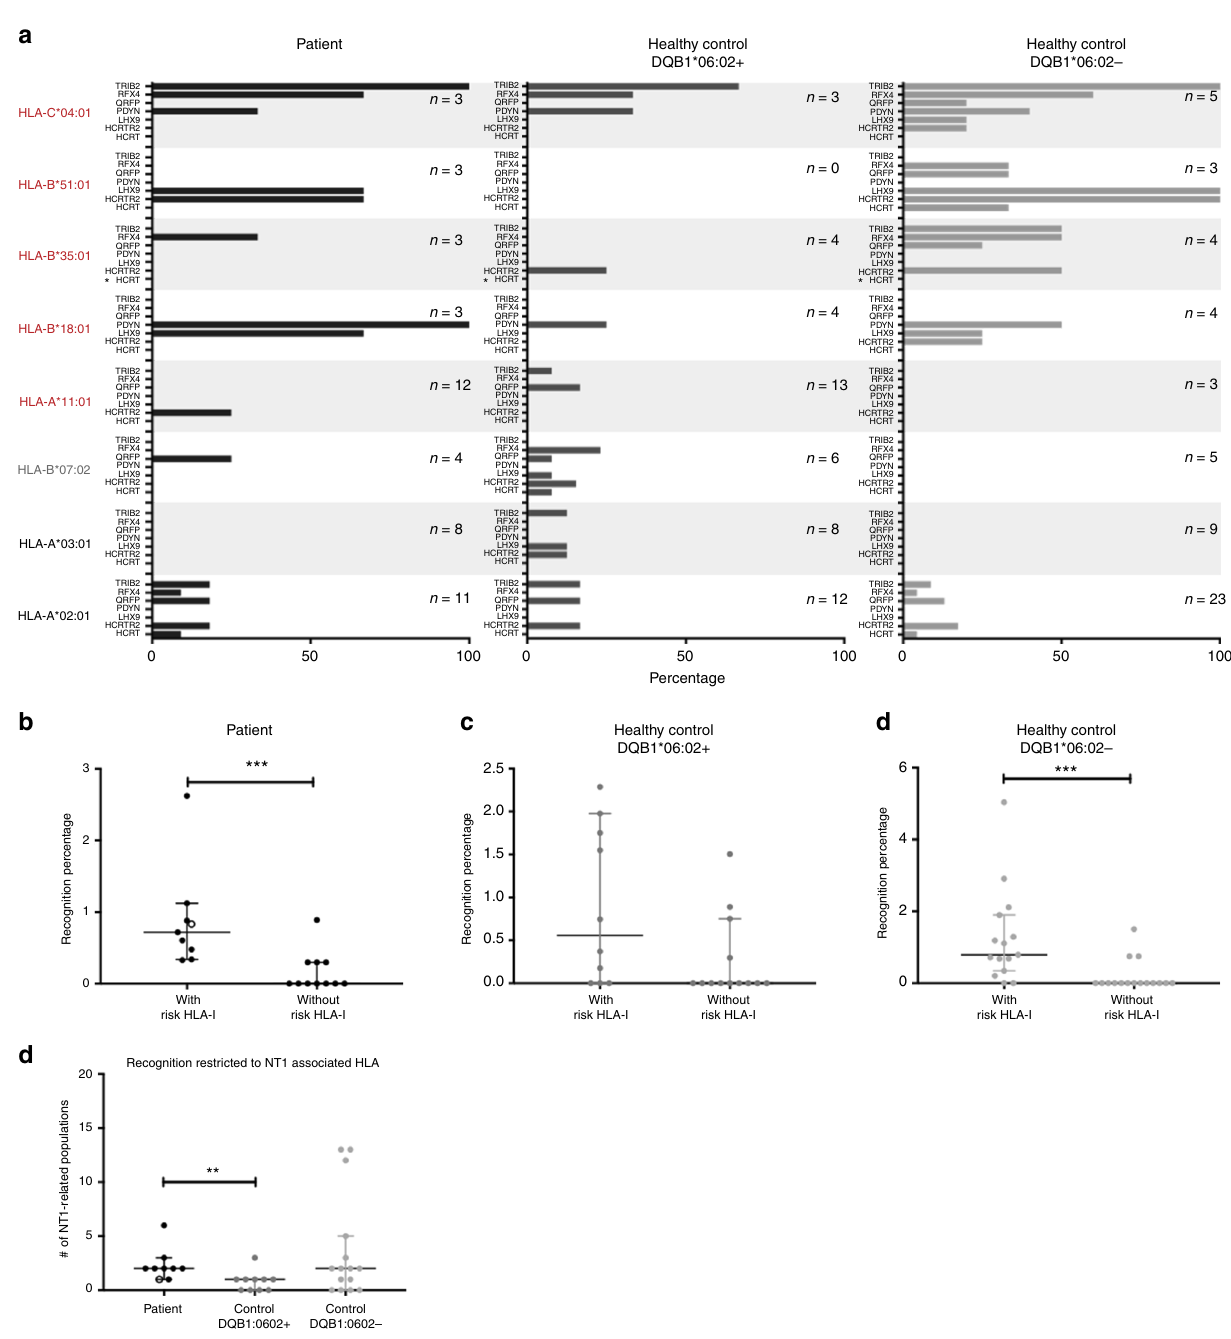
Fig. 4 Percentage of donors harboring NT1-related CD8 + T-cell populations and recognition percentages. a The percentage of donors for each protein-HLA combination with recognition of one or more peptides. n = the number of donors that were positive for the given HLA type and thus included in the group. NT1-associated, protective, and neutral HLA types are indicated in red, gray, and black, respectively. Star (*) denotes a protein and HLA combination for which no peptides were predicted to be binders. The fraction of pMHC recognized by T cells out of the total pool of pMHC combinations used to screen the given donor (recognition percentage), is determined for donors with or without a risk-associated HLA-I allele, b in the patient cohort, p = 0.0004 (***), n = 9 and 11 with or without risk HLA-I allele, respectively, c in HLA-DQB1*06:02-positive healthy controls, n = 10 and 13 with or without risk HLA-I allele, respectively, and d in HLA-DQB1*06:02-negative healthy controls, p = 0.0003 (***), n = 15 and 14 with or without risk HLA-I allele, respectively, (Mann – Whitney test). The recognition percentage for a given donor was calculated as (the number of recognized peptides/total number of peptides used to screen the given patient)*100. e The number of CD8 + T-cell populations speci fi c toward peptides restricted to an NT1-associated HLA allele, p = 0.0041 (**), (Mann – Whitney test). Open symbol denotes the one patient that was HLA-DQB1*06:02 negative. Bars represent median values with 95%